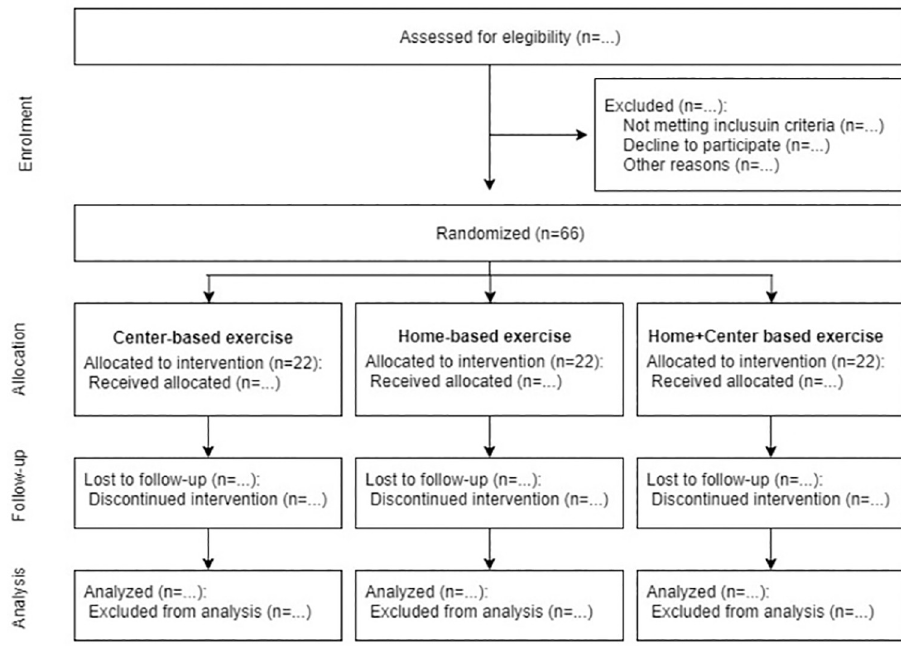
Fig 1. Schematic representation of participant recruitment and